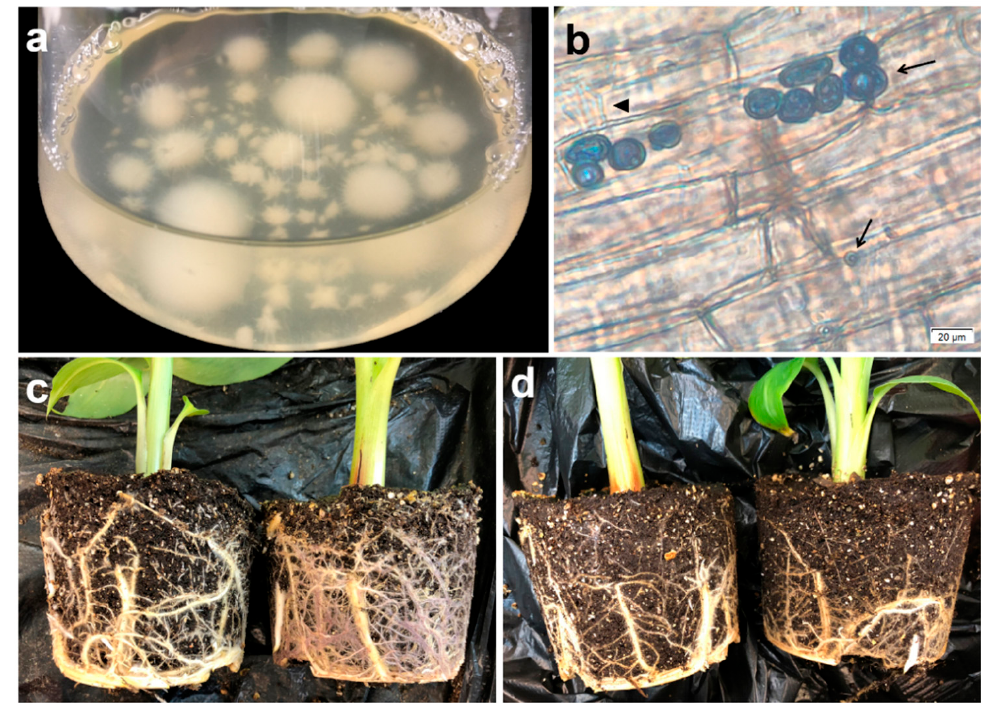
Figure 1. P. indica colonization in banana roots. ( a ) P. indica inoculation solution and ( b ) typical Figure 1. P . indica colonization in banana roots. ( a ) P . indica inoculation solution and ( b ) typical trypan blue detection result of P. indica colonization in banana root. Arrows represent P. indica trypan blue detection result of P . indica colonization in banana root. Arrows represent P . indica chlamydospores; the triangle represents P. indica hyphae. ( c ) Roots of P. indica -colonized banana and chlamydospores; the triangle represents P . indica hyphae. ( c ) Roots of P . indica -colonized banana ( d ) roots of non-inoculated and ( d ) roots of non-inoculated controls.